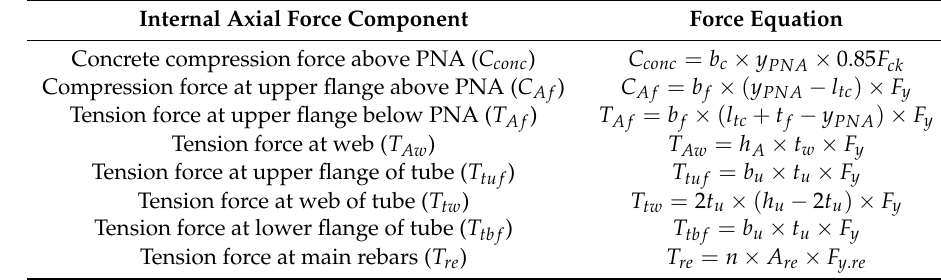
Table 8. Internal force components in case the plastic neutral axis exists at the